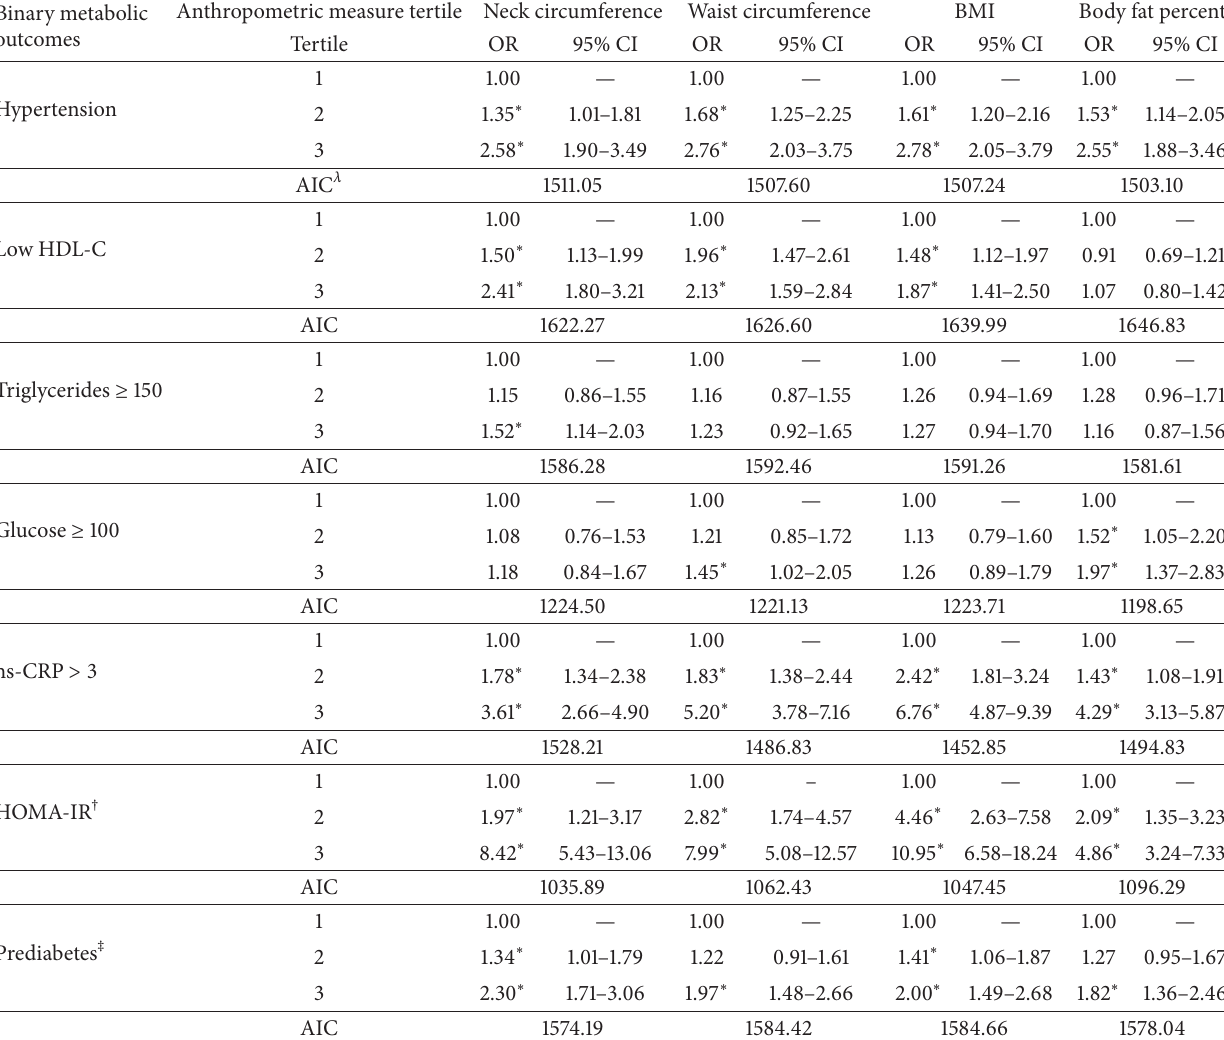
Table 5: Logistic regression for associations between anthropometric measures and metabolic measures including components of metabolic syndrome ∗∗